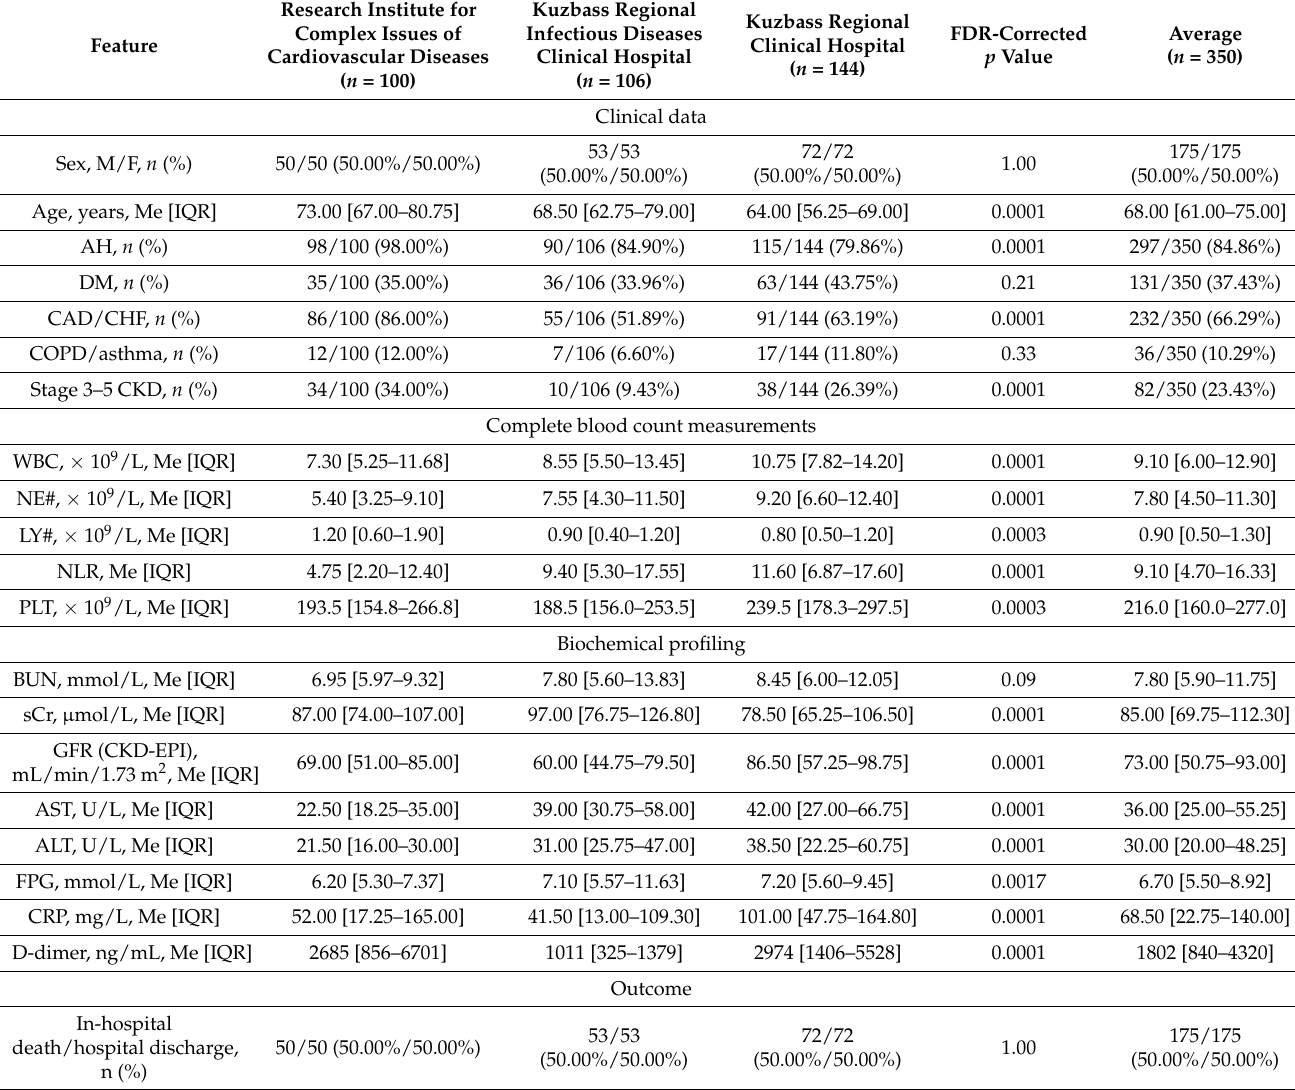
Table 1. Descriptive statistics across three centers participating in the